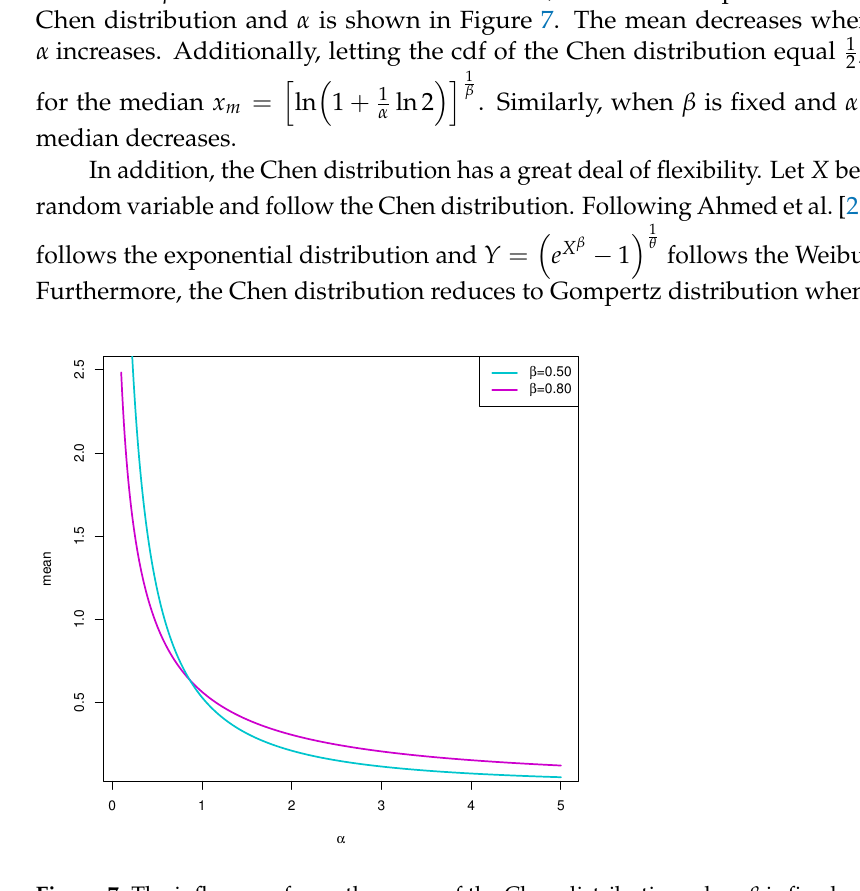
(cid:0) R i 1 , R i 2 , · · · , R im